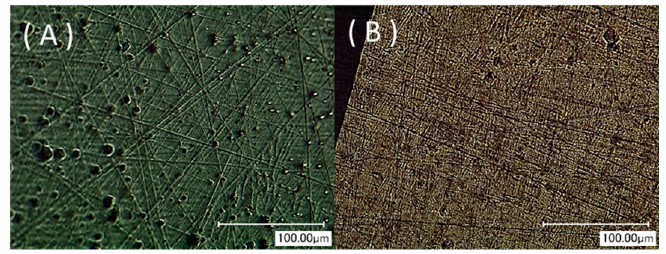
Figure 8. Photomicrographs of the Cr film heater ( A ) and the Cu film heater ( B